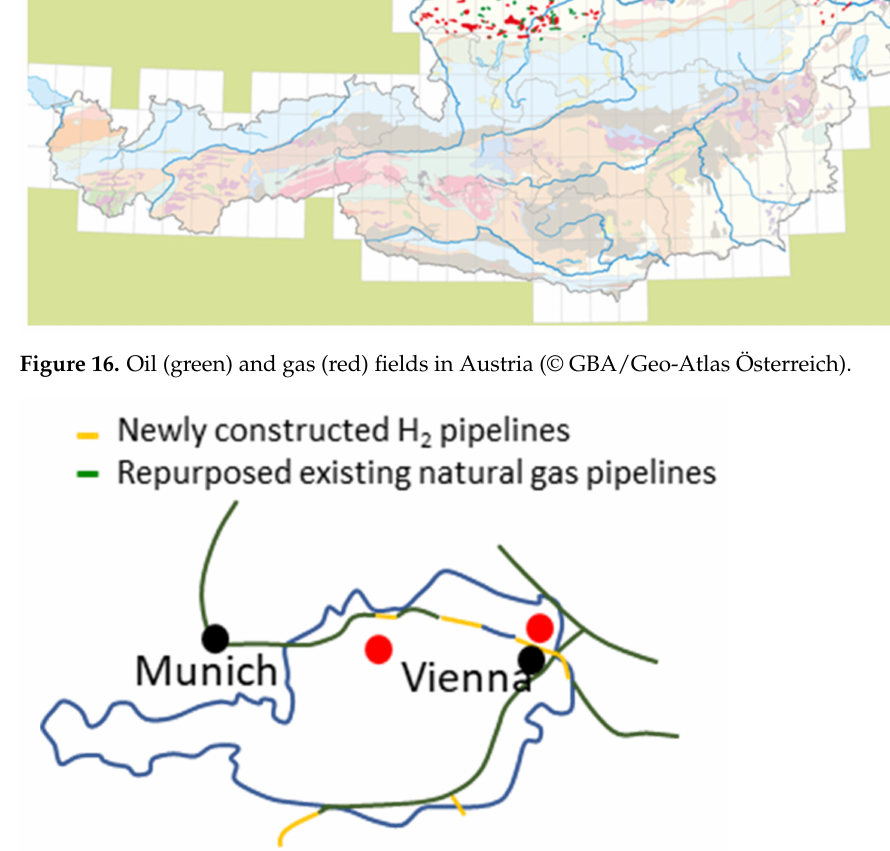
Figure 17. Envisaged European hydrogen gas distribution grid with the location of the two areas with gas fields (red dots) in